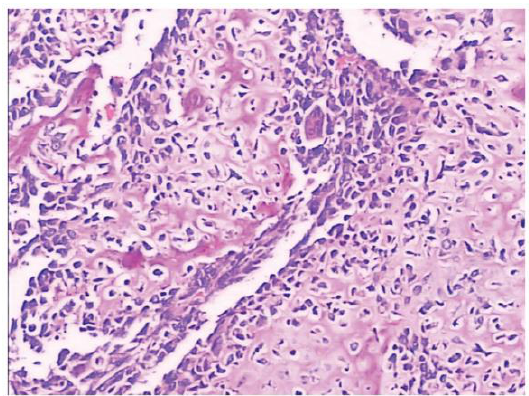
Figure 4: Chondroblastic osteosarcoma under microscopic field (H&E; 20x), (Zheng et al.,